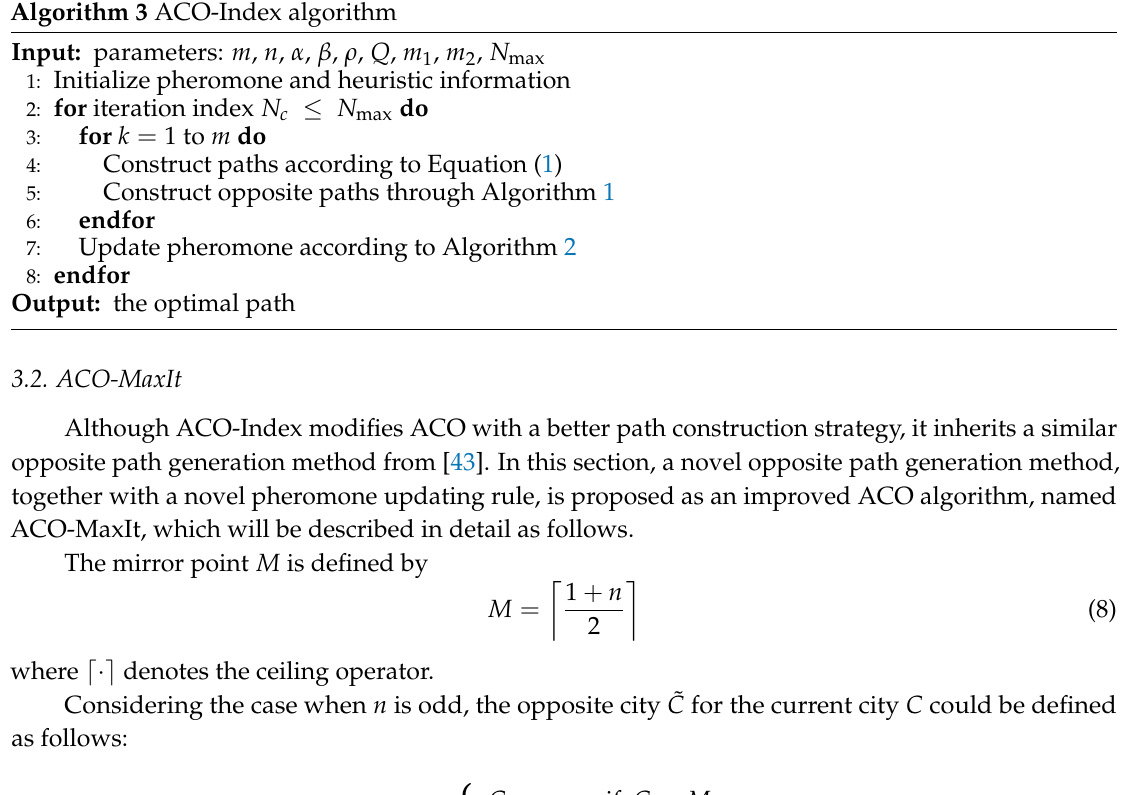
Algorithm 3 ACO-Index algorithm